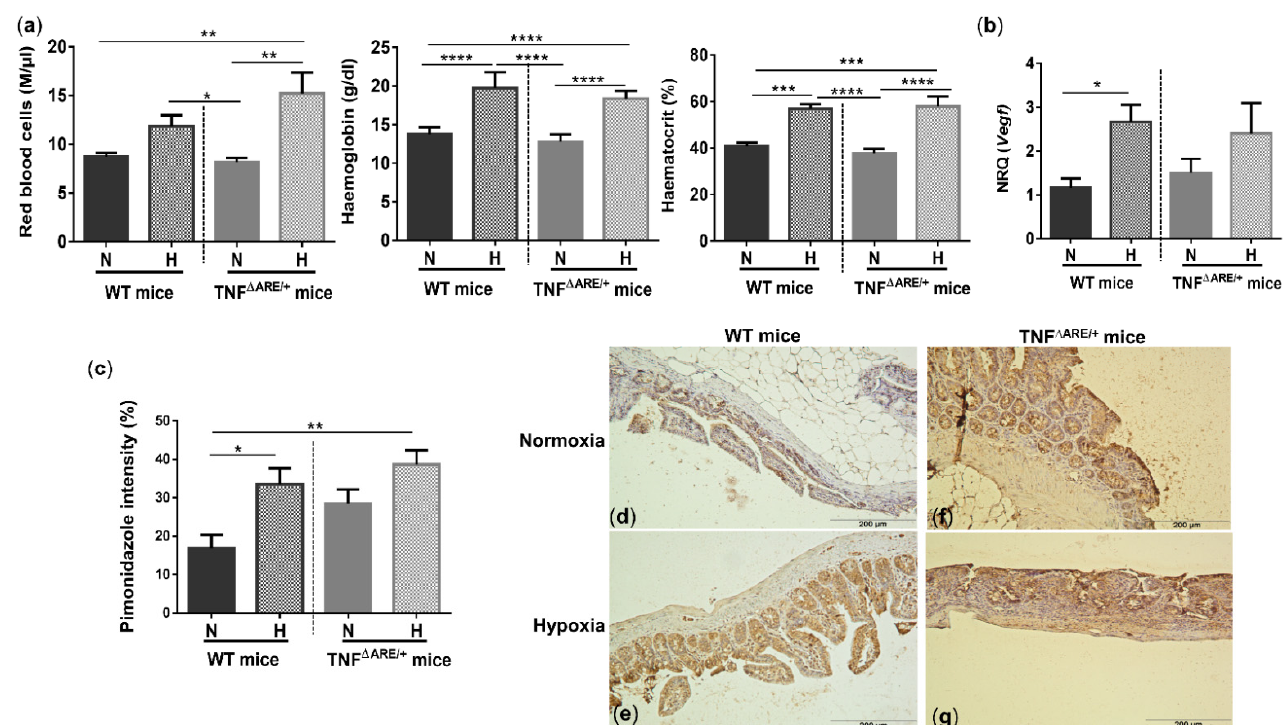
Figure 2. Systemic and ileal hypoxic markers are increased in mice housed in environmental hypoxia. ( a ) Red blood cells, haemoglobin and haematocrit concentrations, ( b ) ileal vascular endothelial growth factor (Vegf) mRNA expression and ( c ) ileal pimonidazole intensity in WT and TNF ∆ ARE/+ mice housed in hypoxia and normoxia. Representative images of the pimonidazole staining in a ( d ) WT mouse housed in normoxia; ( e ) WT mouse housed in hypoxia; ( f ) TNF ∆ ARE/+ mouse housed in normoxia and ( g ) TNF ∆ ARE/+ mouse housed in hypoxia. * p < 0.05, ** p < 0.01, *** p < 0.001, **** p < 0.0001. Data are represented as the mean ± SEM. N: Normoxia; H: Hypoxia.